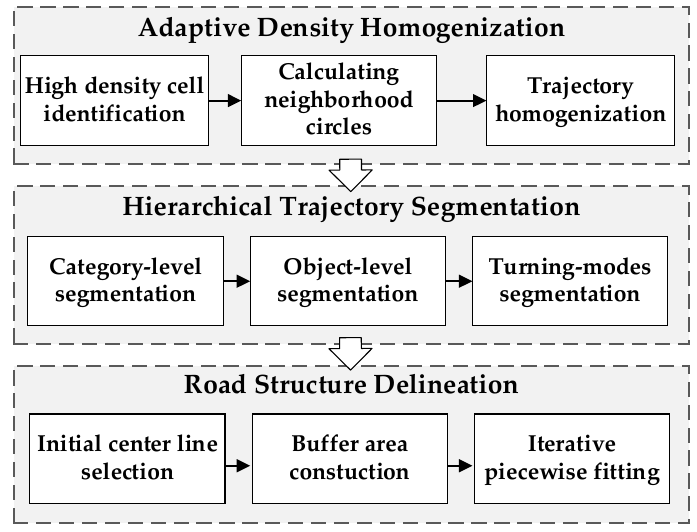
Figure 2. The workflow of the proposed